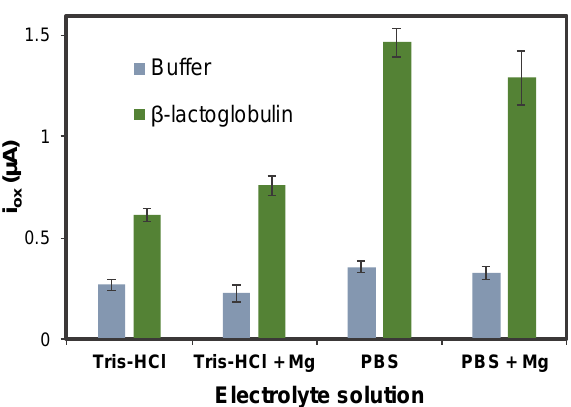
Figure 3. Optimization of the electrolyte solution. Experimental conditions: [ β -LG] = 0 and 5 ng·mL − 1 , [Apt-MB] = 1 µM, incubation time: 45 min, oxidation DPV recorded between − 0.60 V and +0.15 V, using the following conditions: modulation time: 0.02 s; interval time: 0.5 s; step potential 0.005 V; modulation amplitude 0.10 V. Solutions made in 0.1 M PBS, 150 mM NaCl pH = 7.4. Data are given as average ± SD (n =